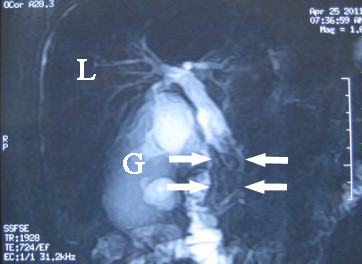
Magnetic resonance imaging findings on 25 April 2011. Magnetic resonance cholangiopancreatography, showing irregular hypointense areas in the common bile duct (white arrows) with obvious dilation of the distal bile ducts. G, gallbladder; L, liver.